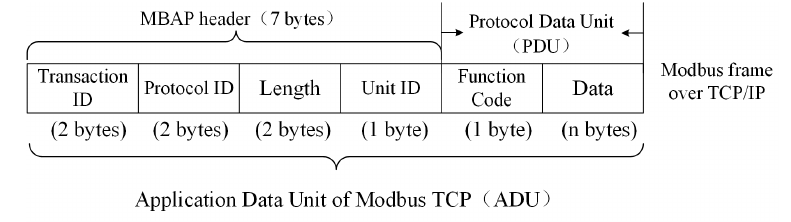
Figure 1. Structure of Modbus TCP. MBAP, Modbus application protocol.